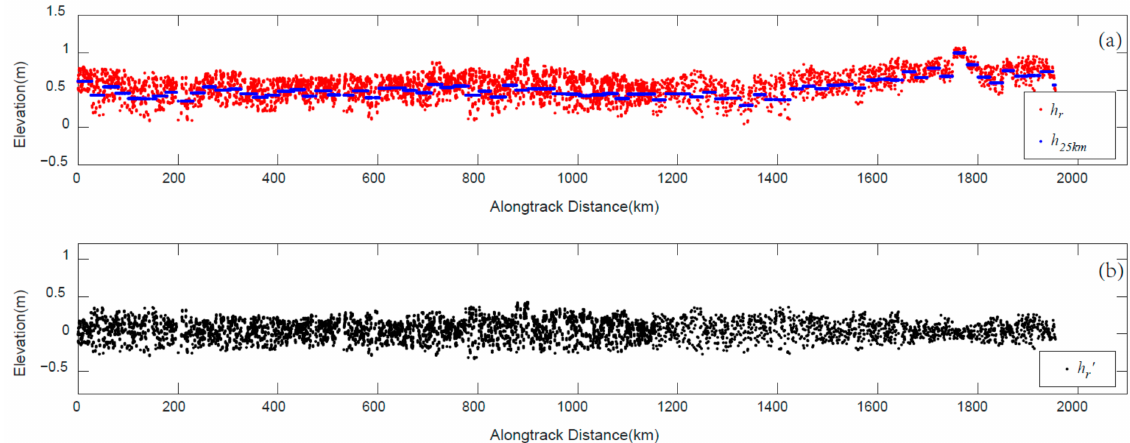
Figure 3. A sample of Envisat elevation profiles. The red points in ( a ) are the relative elevation h r values; the blue points in ( a ) are h 25 km values, defined as the 25 km running mean of h r ; and the black points in ( b ) are the modified relative elevation h r (cid:48)